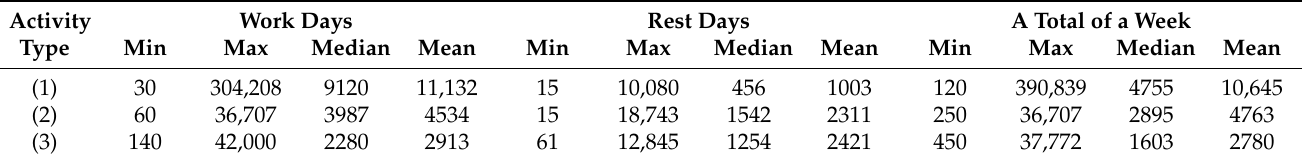
Table A3. Exposure level of three kinds of activities.